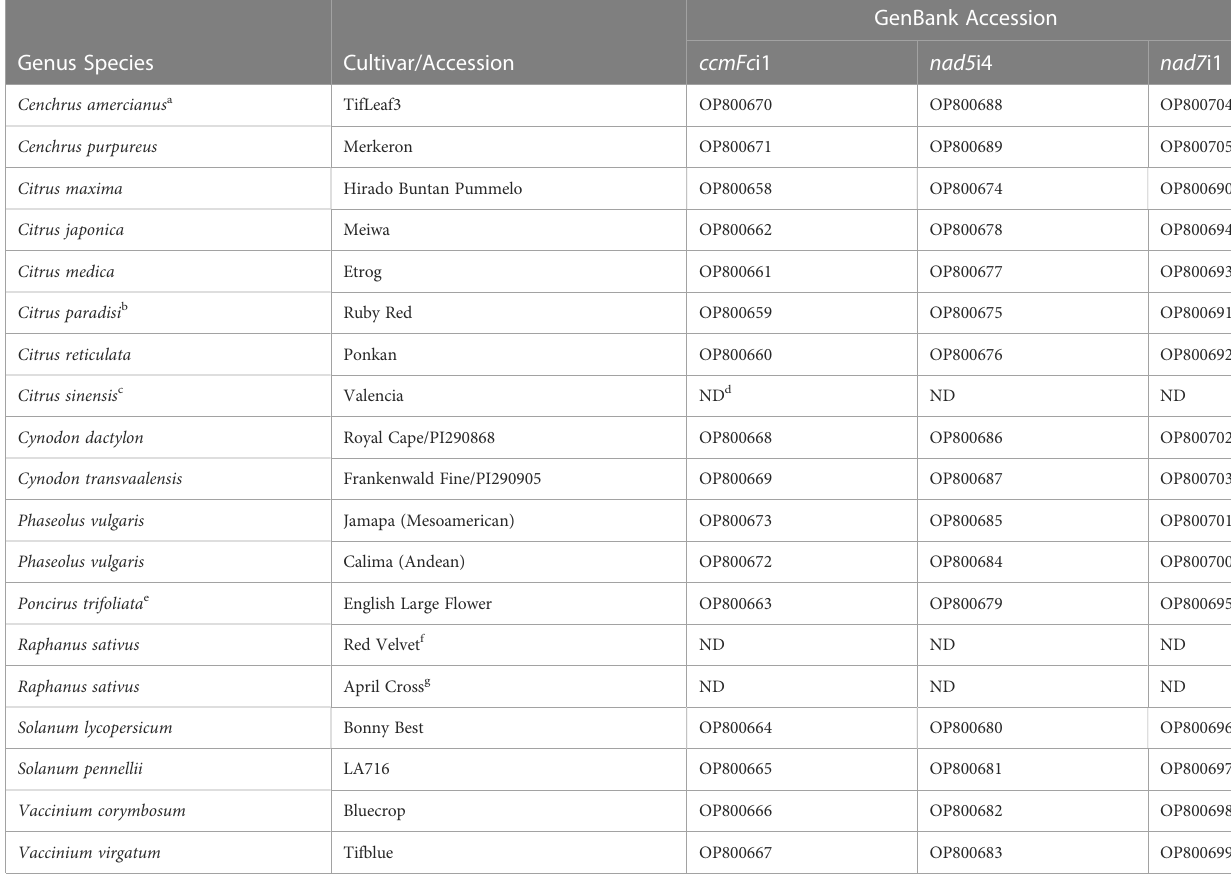
TABLE 1 Plant materials and intron sequence GenBank accession